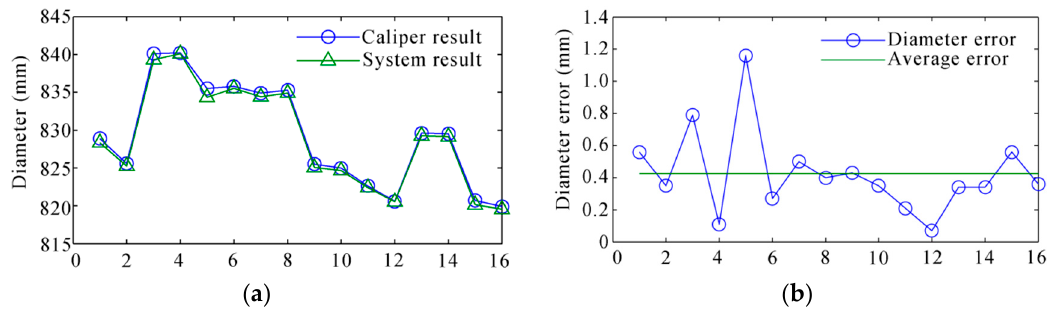
Figure 25. The comparison between the system result and the diameter caliper. ( a ) The diameter result; ( b ) the diameter error. Table 3. Wheel diameter results of the 3D scanner and the system (in millimeters).